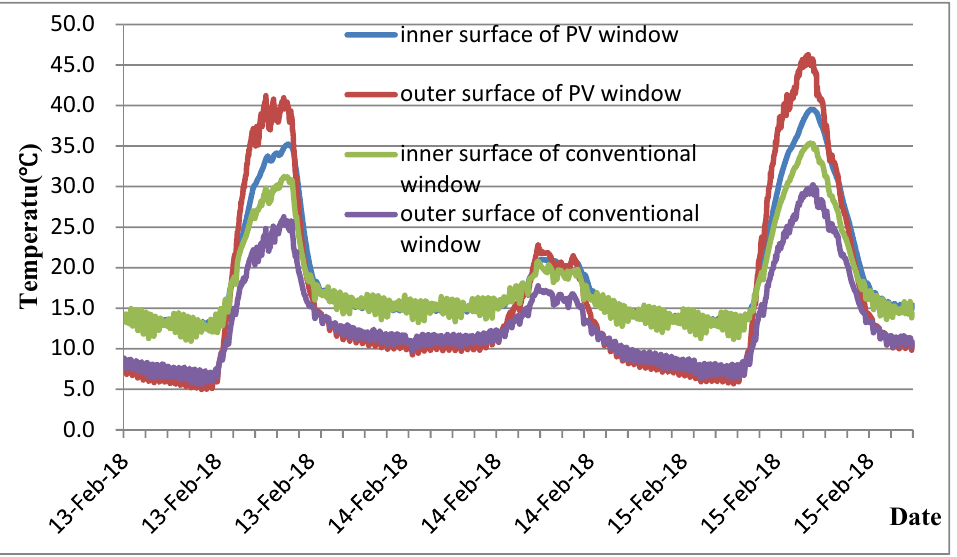
Figure 9. Surface temperature of windows.